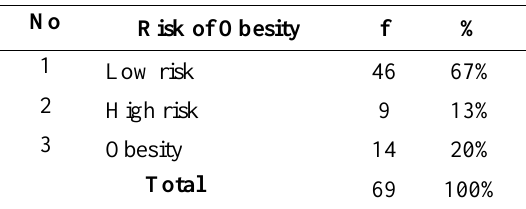
Tabel 3. Distribution of the respondents